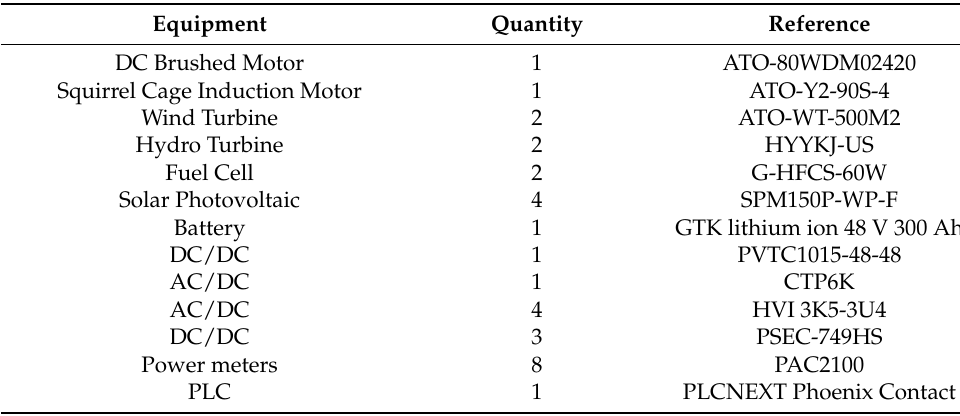
Table 9. Summary of the different selected equipment for the test